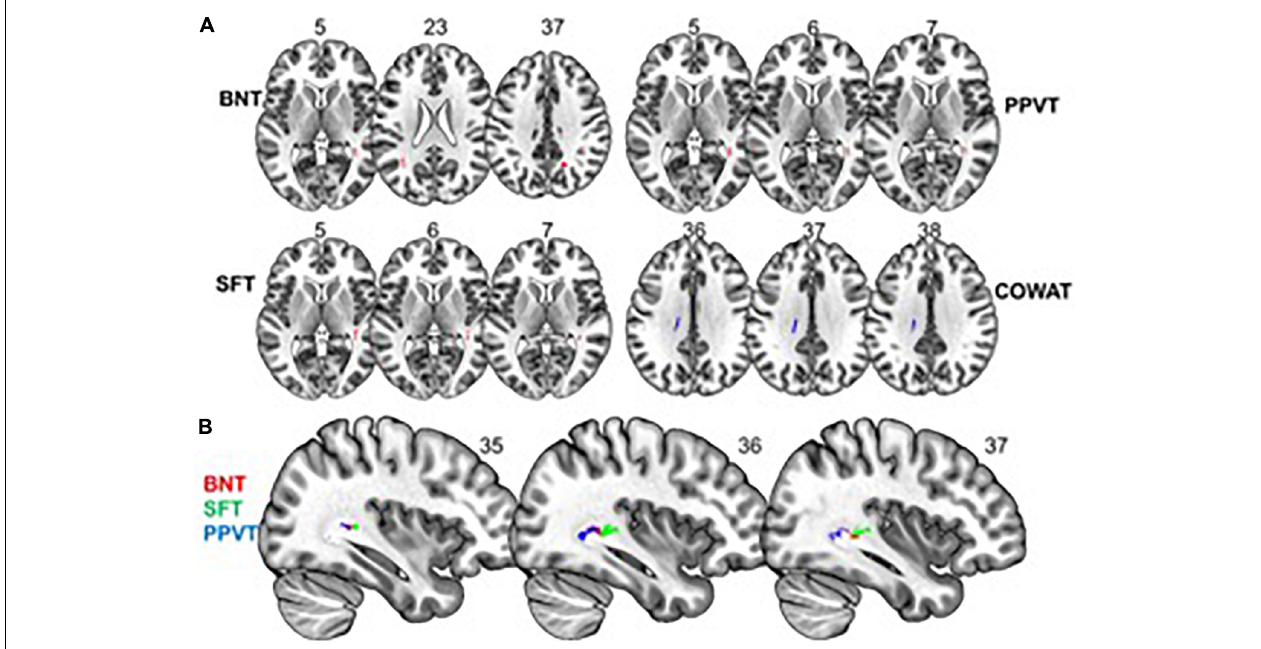
FIGURE 2 | Significant correlations between FA and behavioral scores ( p < 0.05, cluster-wise FDR corrected for multiple comparisons). (A) FA shows positive relationships with BNT, PPVT, and SFT performance and a negative relationship with COWAT performance. (B) Significant correlations between FA and BNT, SFT, and PPVT overlap in a region of the right inferior fronto-occipital fasciculus. Pictures are in neurological convention with left side in the figure corresponding to the left side of the brain.